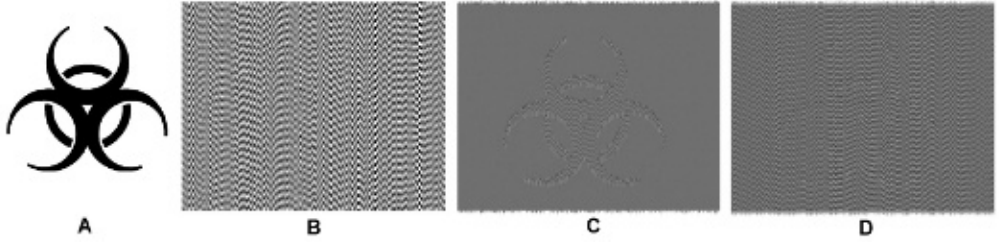
Fig. 1. Visual decoding of the secret image: A – the secret image; B – encoded secret image; C – time averaged image leaks the secret; D – time averaged image when parameters of oscillation are